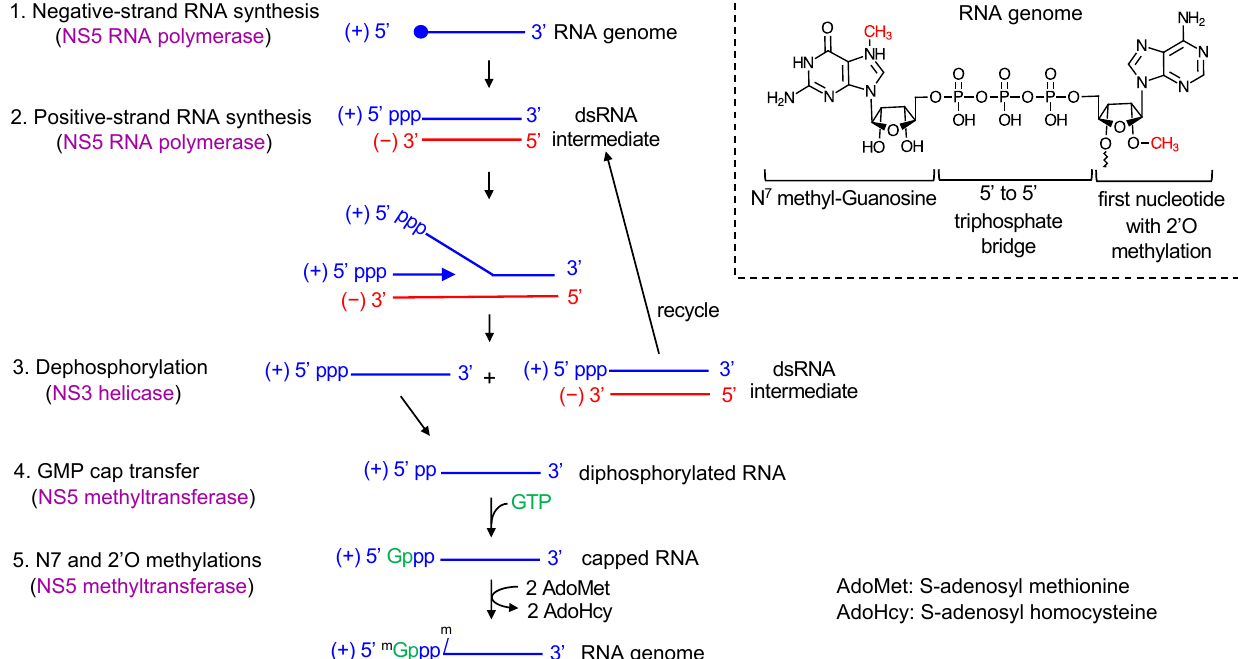
Figure 2. Viral RNA synthesis. Both negative-strand (red) and positive-strand (blue) RNA synthesis are carried out by viral polymerase NS5. First, NS5 synthesizes negative-strand RNA using the genomic positive-strand as a template, resulting